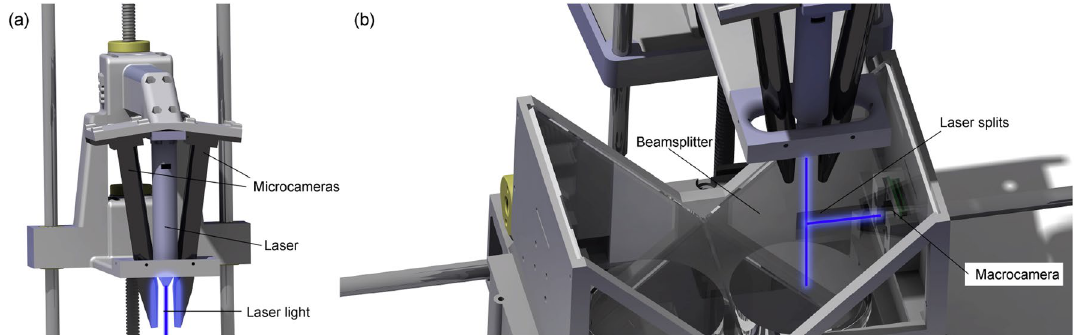
Figure 3. The head. The image was obtained with SOLIDWORKS 2020 SP3.0. ( a ) The head has two microcameras and one laser. ( b ) The head and de carriage are assembled, where the laser light trajectory is shown.